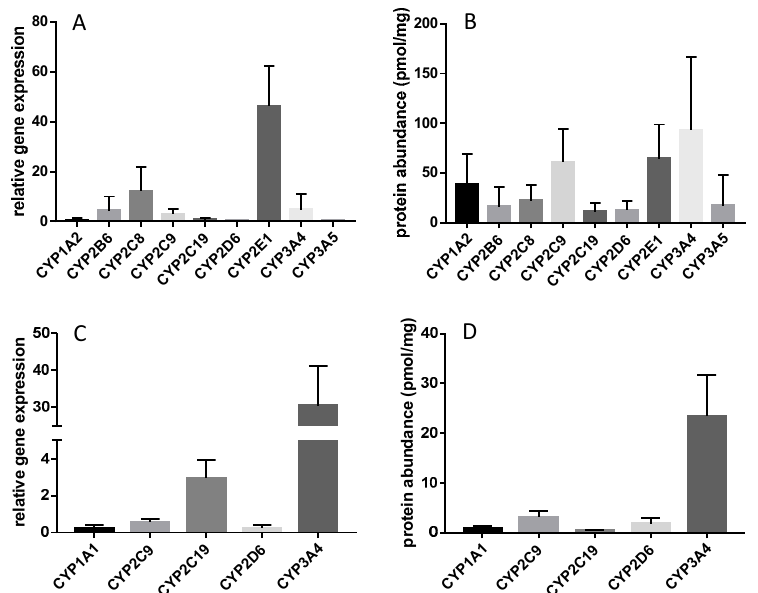
Figure 1. Comparative intestinal and hepatic gene expression and protein abundance of CYP1A1 and CYP1A2 (mean ± SD). Relative gene expression and absolute protein abundance of clinically relevant CYP450 enzymes in the human liver is presented in section ( A , B ) (data taken from Drozdzik et al. 2019 ( A ) and Achour et al. 2014 ( B )). Sections C and D show relative gene expression and absolute protein abundance of clinically relevant CYP450 enzymes in the human small intestine observed in 30 (( C ), own unpublished data) and 28 human jejunal tissue samples (( D ), Miyauchi et al. 2016).